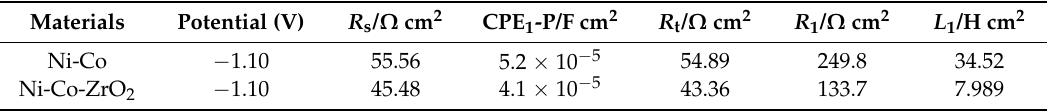
Table 3. Impedance parameters of materials electrodeposition at − 1.10